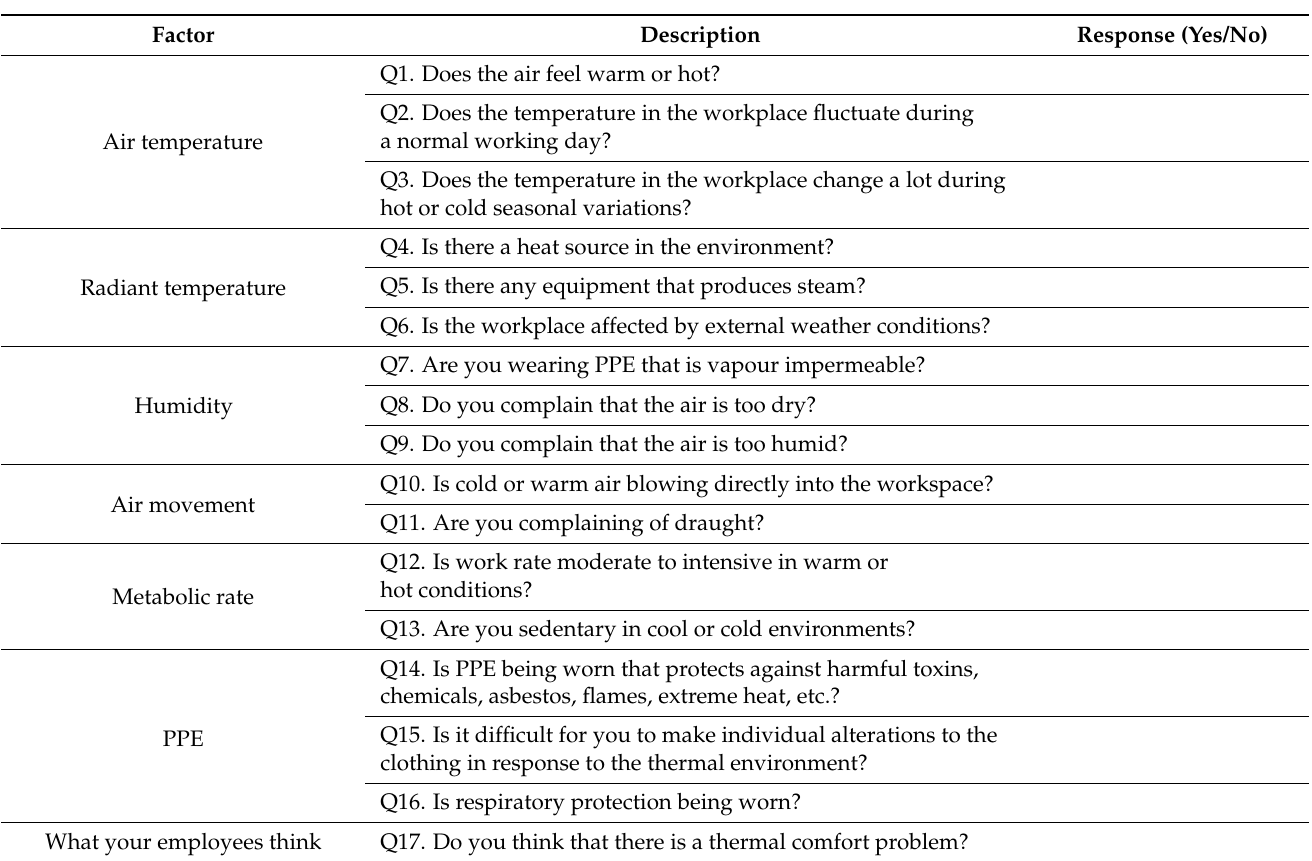
Table 2. Thermal comfort